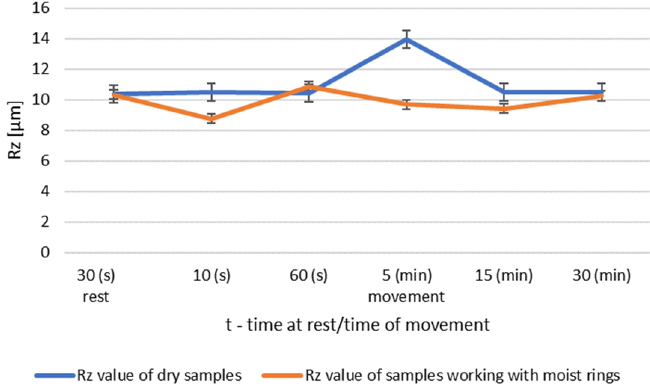
Figure 4. Comparison of Ra values of dry and wet ring samples for roughness group I.